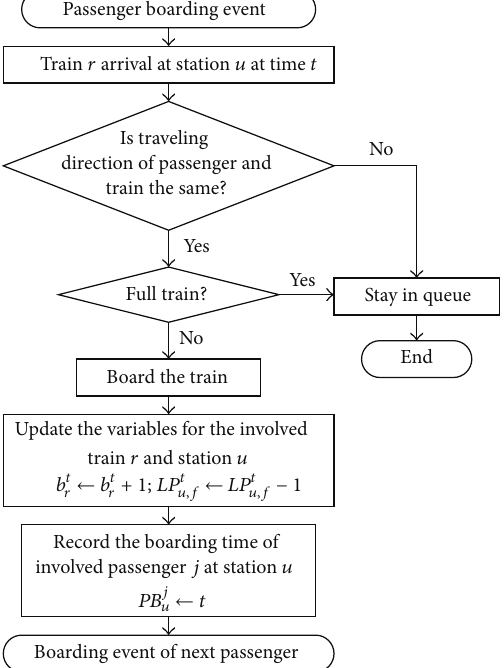
Figure 5: Flowchart of passenger boarding event.